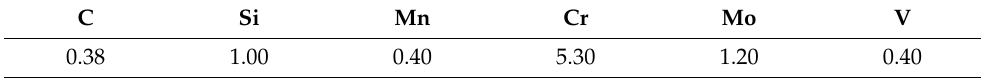
Table 2. Composition of alloying element in AISI H11 (values specified in wt%).